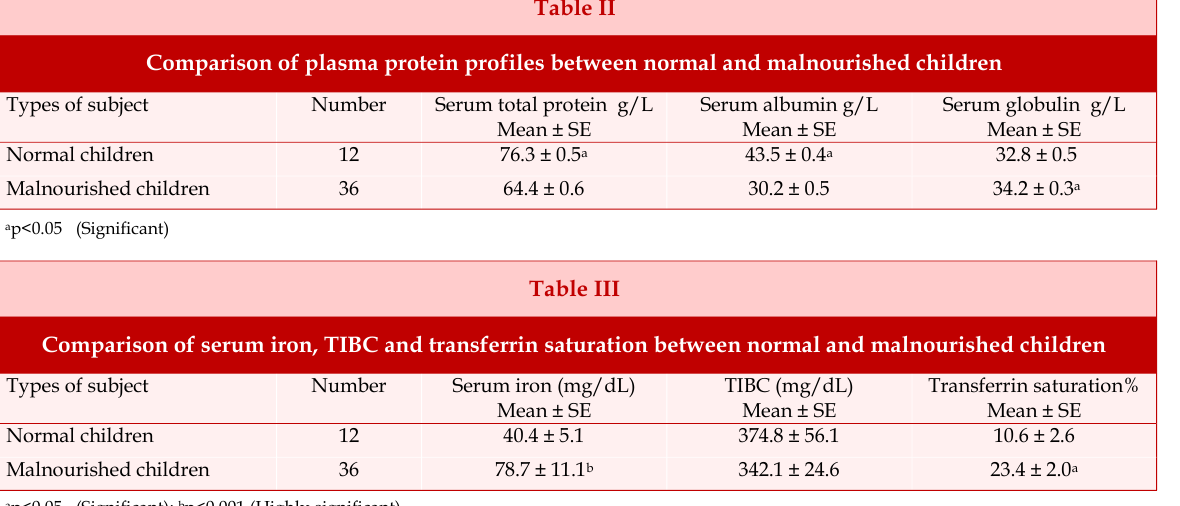
0.5 g/L). On the other hand, mean serum globulin level (34.2 ± 0.3 g/L) in malnourished children higher than in normal children (32.8 ± 0.5 g/L).